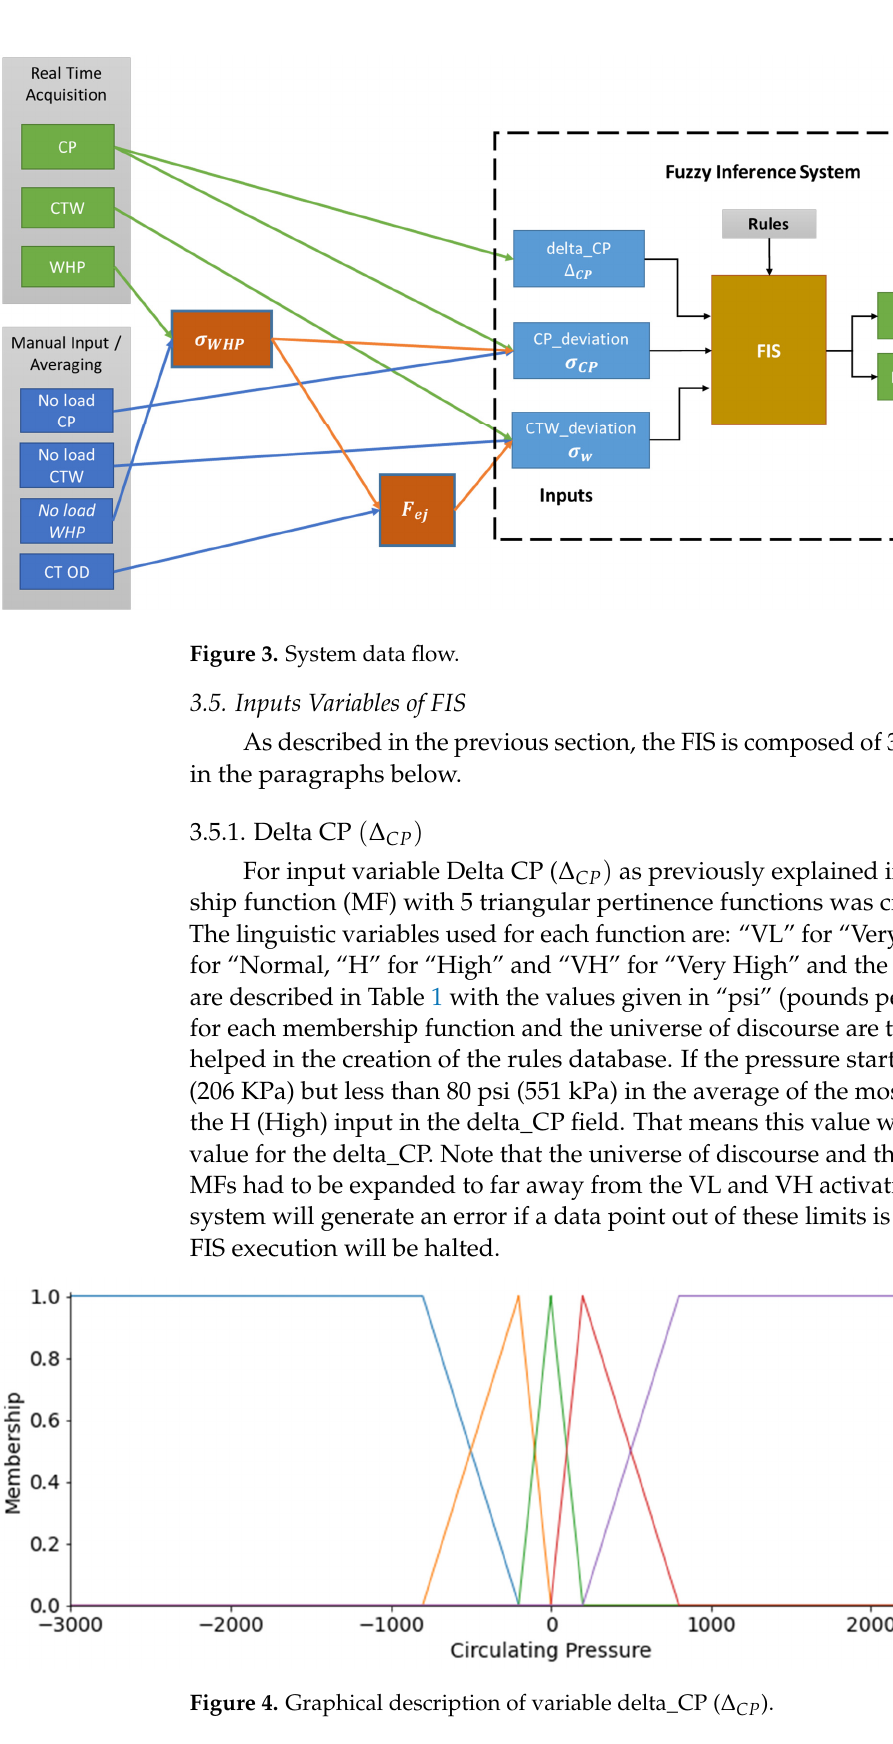
Figure 4. Graphical description of variable delta_CP ( ∆ (cid:3004)(cid:3017) ).